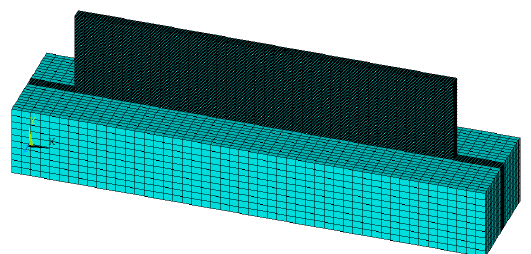
Figure 9. Finite element model and meshing of thin-walled (with substrate).